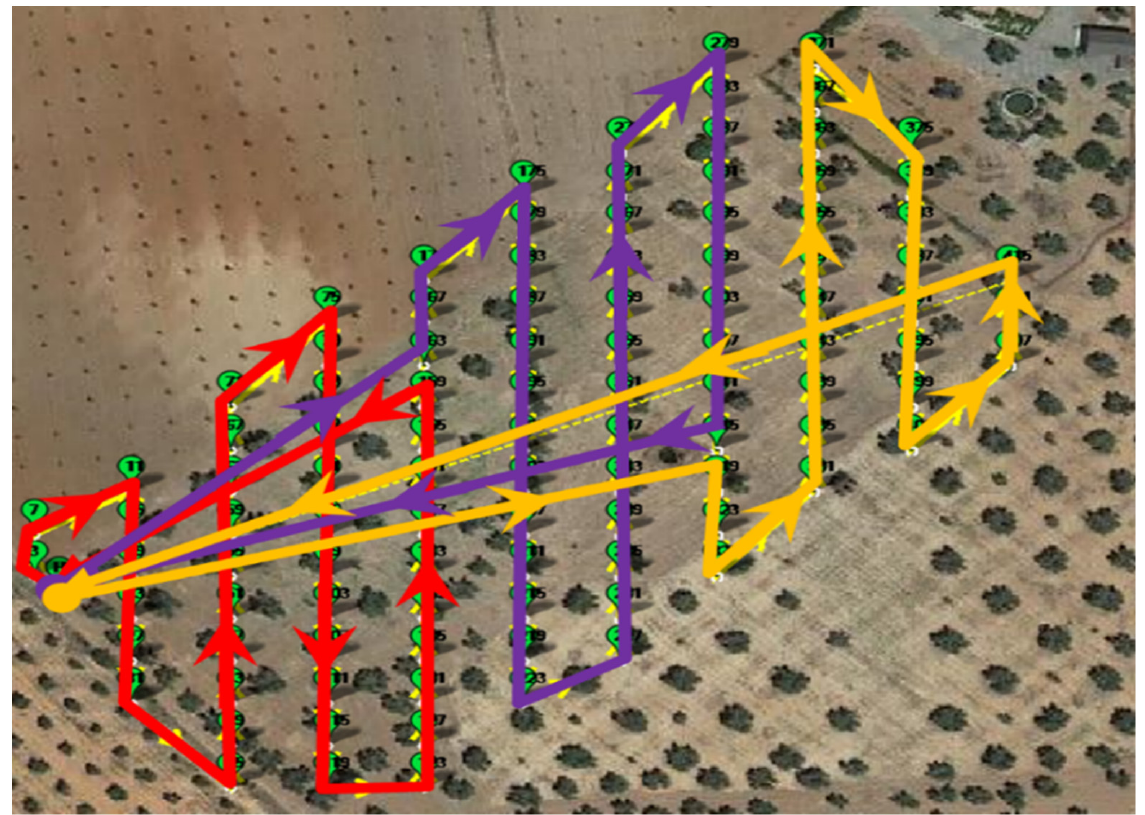
Figure 7. Illustration of a route division into three sub-routes.